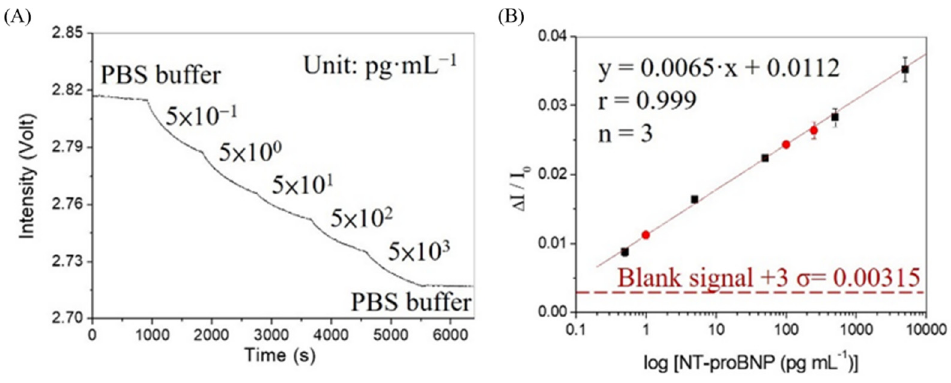
Figure 6. ( A ) Sensorgram in response to sequential multiple injections of NT-proBNP standards with concentrations of 0.5, 5.0, 50, 500, and 5000 pg ⋅ mL − 1 . ( B ) Corresponding standard calibration curve for NT-proBNP, with all calibration points denoted as black squares ( n = 3). Sensor responses with serum-spiked NT-proBNP standards at concentrations of 1.0 × 10 − 12 , 1.0 × 10 − 10 , and 2.5 × 10 − 10 g ⋅ mL − 1 are denoted as red circles ( n = 3). Red dashed line represents the BAL.